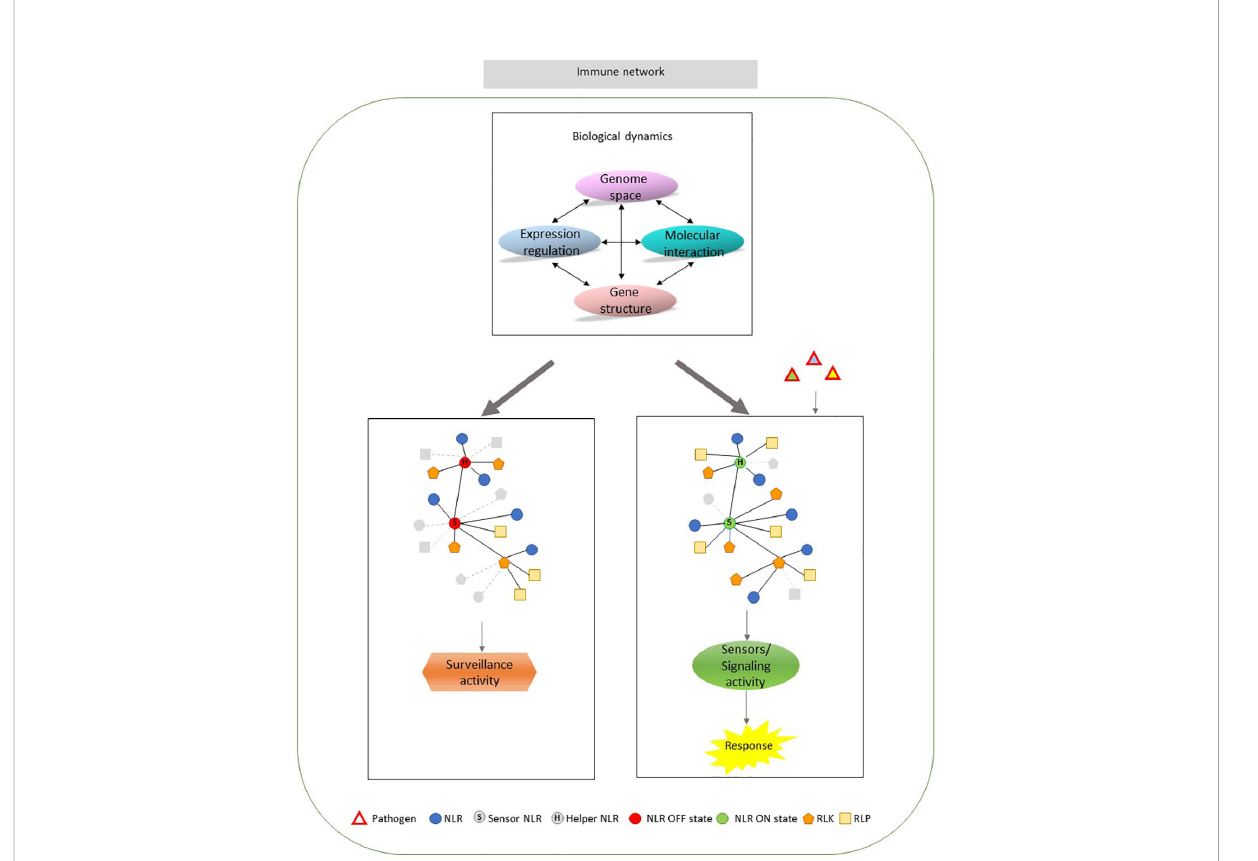
FIGURE 1 Organizational overview of plant innate immune system. Upper middle panel. The immune system functioning is modulated by a fi ne control over the pathogen receptor genes (PRGs) activities at different levels (ovals). They include gene structure, genome space, molecular interaction and gene expression regulation. The connections among the different levels show a very complex and dynamic arrangement (indicated by arrows). All the potential levels can determine the loss/gain of connections in PRG network. Left panel. PRGs network organization in plants not challenged by pathogen. NLRs are in a resting state (OFF state) resulting in a PRG surveillance activity to recognize potential pathogen infection. Right panel. PRGs network organization challenged by pathogen. The activation of a sensor NLR and a potential helper (ON state) can initiate a response culminating in innate immunity. The network edges represent every kind of biological interaction in fl uencing the member activity. Gray color indicated the changing connections among members of each network. NLR, nucleotide-binding leucine-rich repeat proteins; RLK, receptor-like kinase; RLP, receptor-like